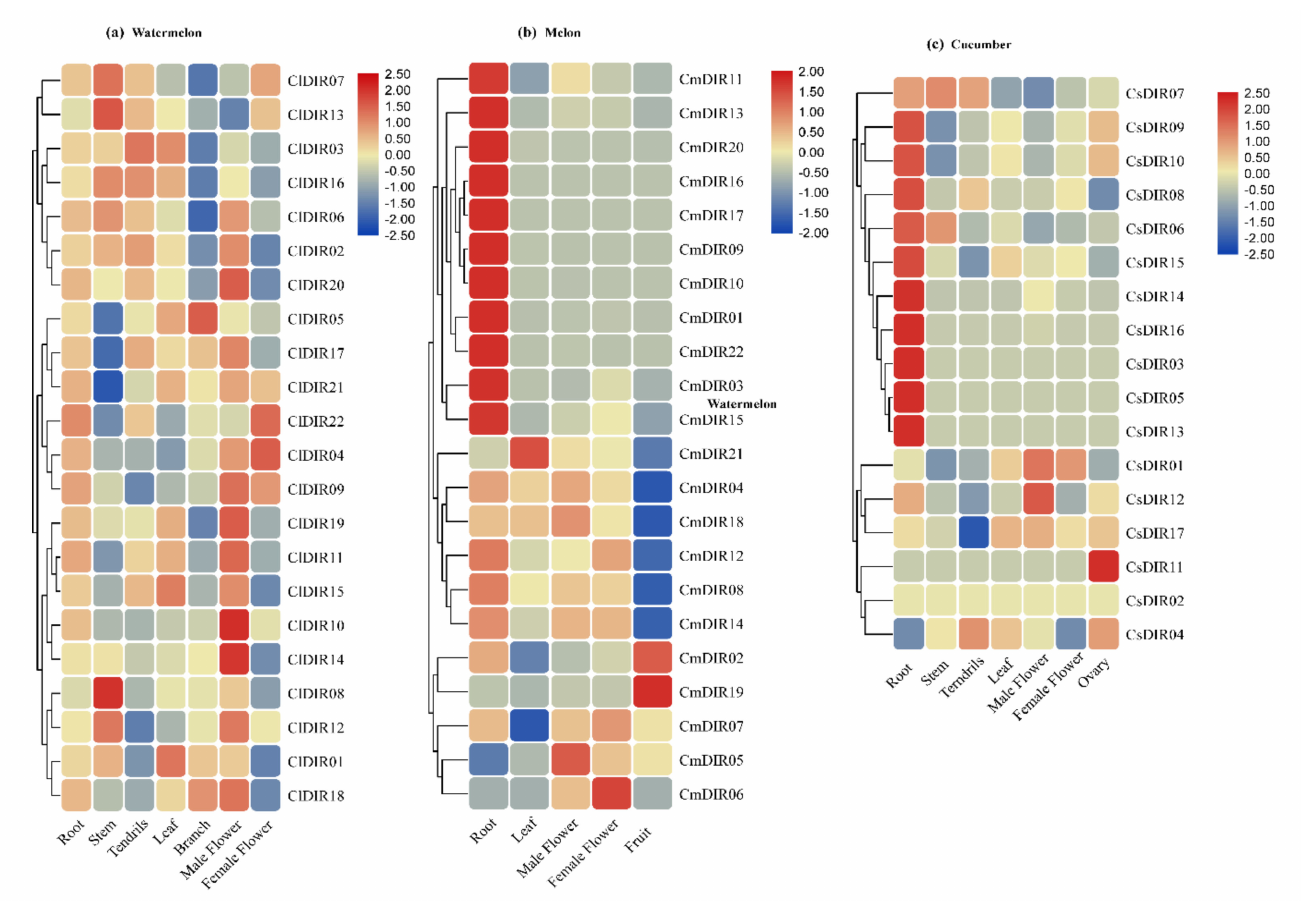
Figure 7. Heat maps representing expression level of all ClDIR, CmDIR and CsDIR genes in different tissues. Normalized Log2 transformation method was used for digital transcript values. ( a ) Heat map representing expression level of ClDIR genes in various tissue (root, tendril, leaf, stem, different sex form flowers, and ovary) based on qRT-PCR expression. ( b ) Expression of CmDIR in various tissues including root, leaf, flower (male, female) and fruit. ( c ) Digital gene expression data of CsDIR genes in various tissues (root, stem, tendrils, leaf, male/female flower, and